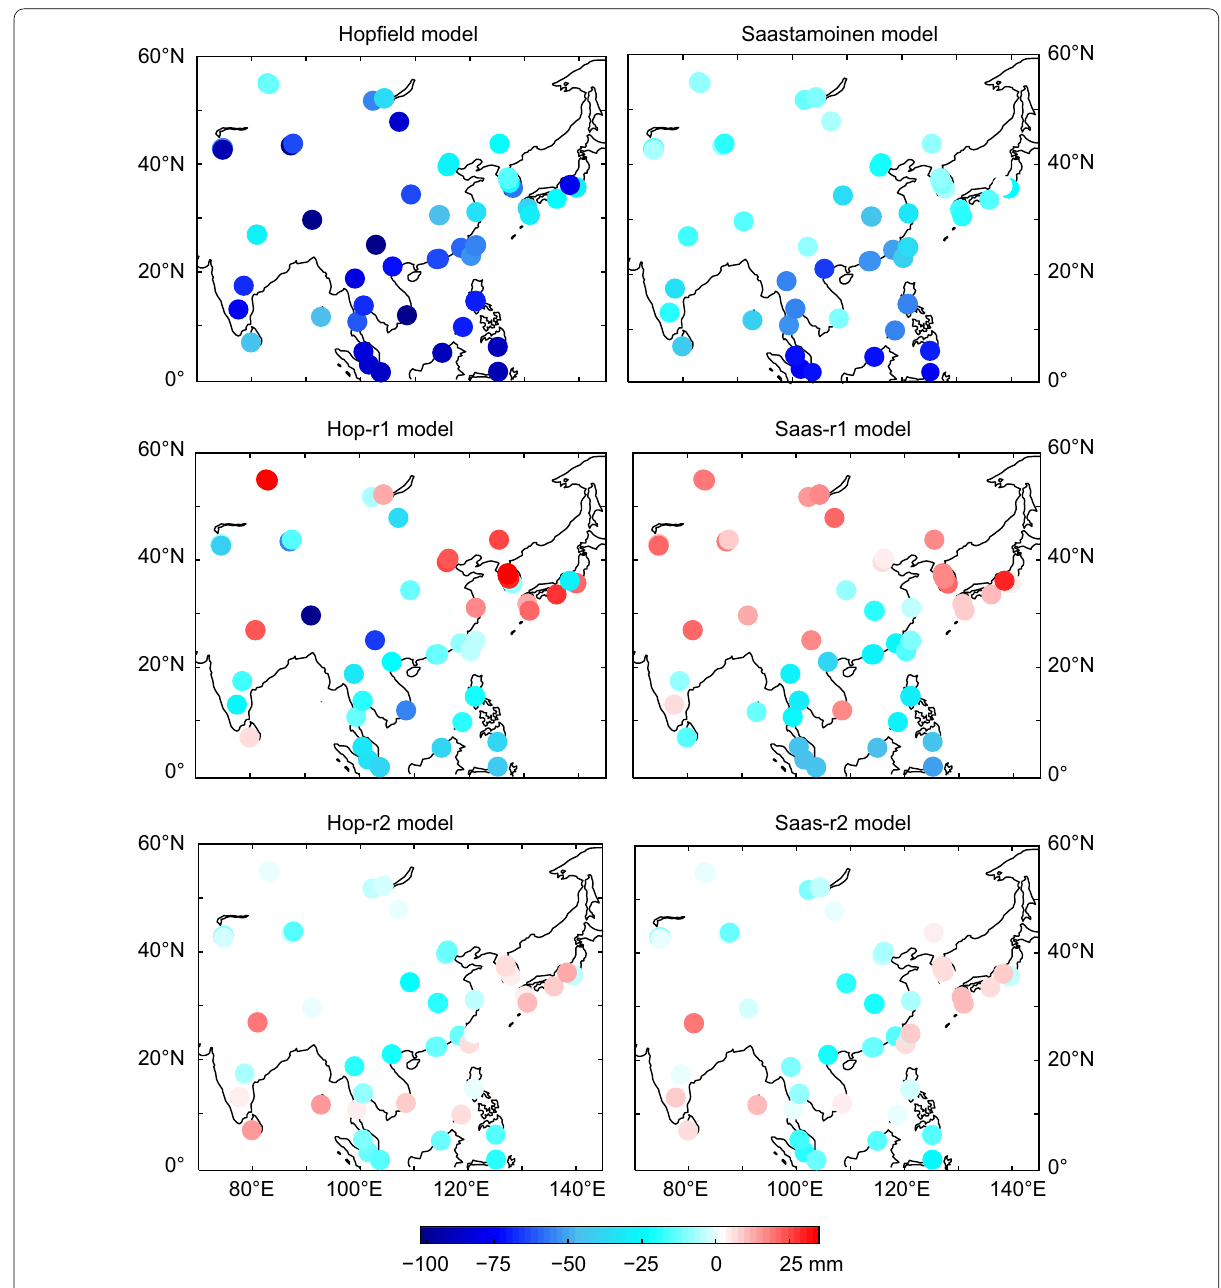
Fig. 3 Maps showing the bias at each site for six